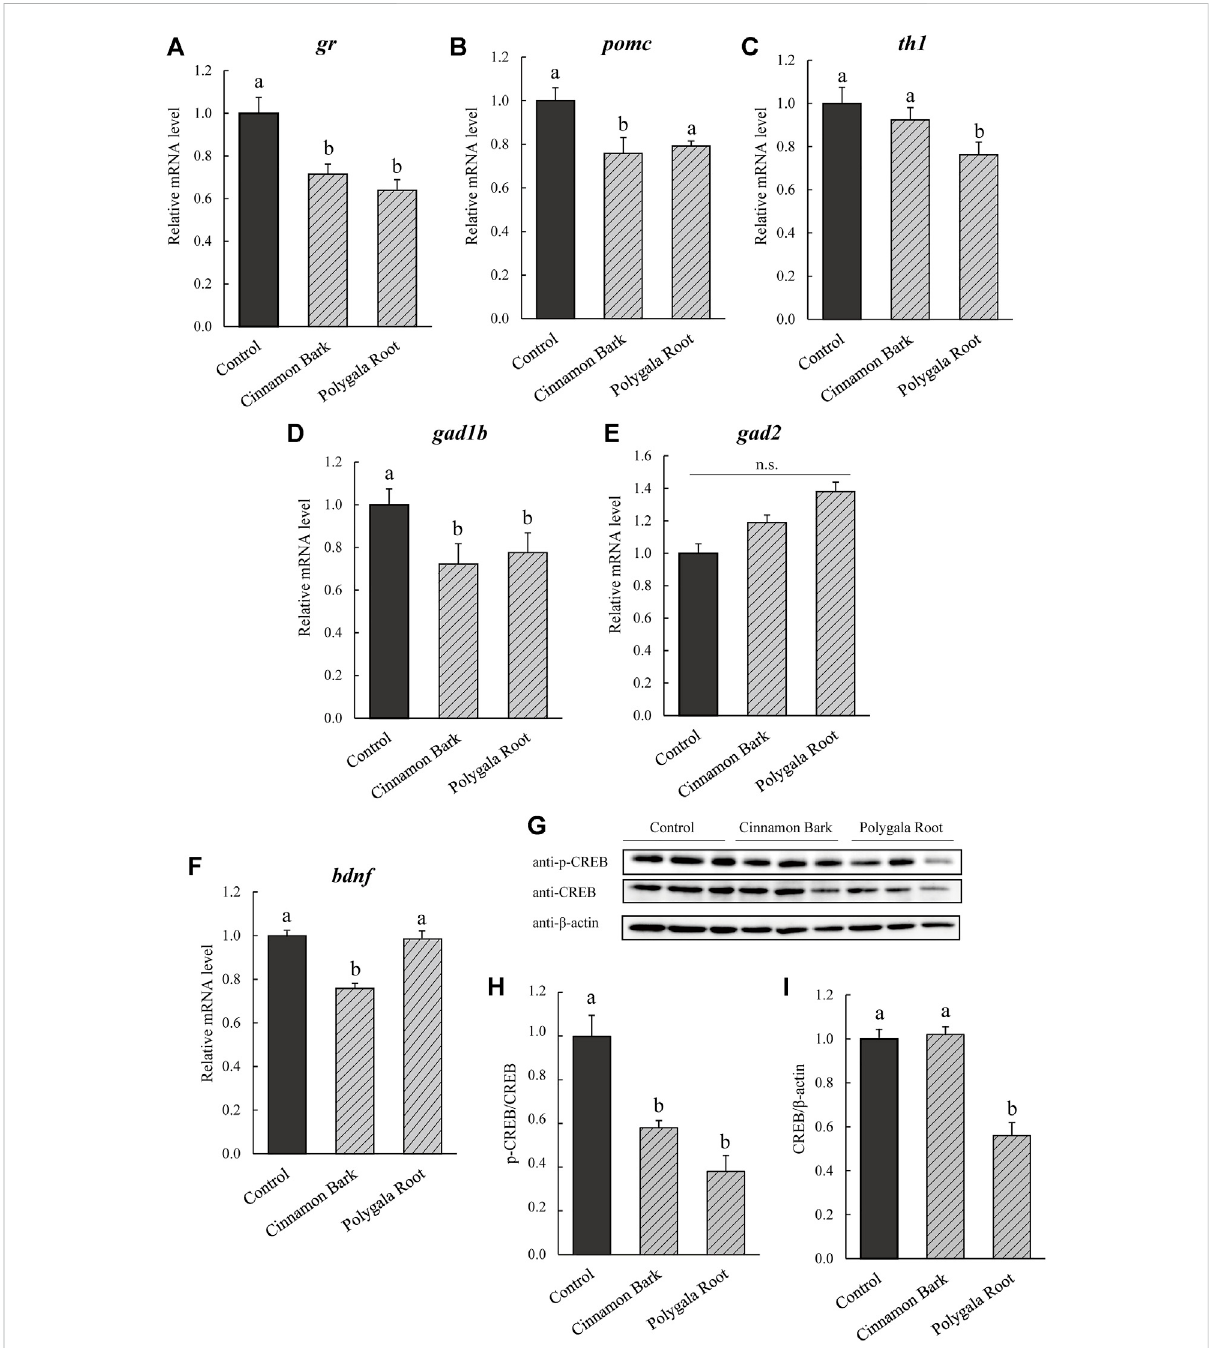
Effect of Cinnamon Bark and Polygala Root on BDNF/CREB in NPY-KO zebra fi sh. mRNA levels of the (A,B) HPA axis, (C) SAM axis, (D,E) GABA -relatedgene,and (F) bdnf wereestimatedbyreal-timePCRusingwholebrainsofthecontrol — andCinnamonBark-andPolygalaRoot-fedNPY-KO zebra fi sh. (A) gr . (B) pomc . (C) th1 . (D) gad1d . (E) gad2 . (F) bdnf . The gene expression level of actb was used as an internal reference. Each gene expression level was relative to that in the control-fed NPY-KO zebra fi sh. n = 5. The protein levels of (G,H) p-CREB and (G,I) CREB were analyzed by immunoblotting with whole-brain lysate of the control — and herbal medicine-fed NPY-KO zebra fi sh. A loading control was used as the (H) total CREB and (I) β -actin. n = 8. Results are shown as mean ± standard error of the mean. There were signi fi cant differences between the different signs. n.s., not signi fi